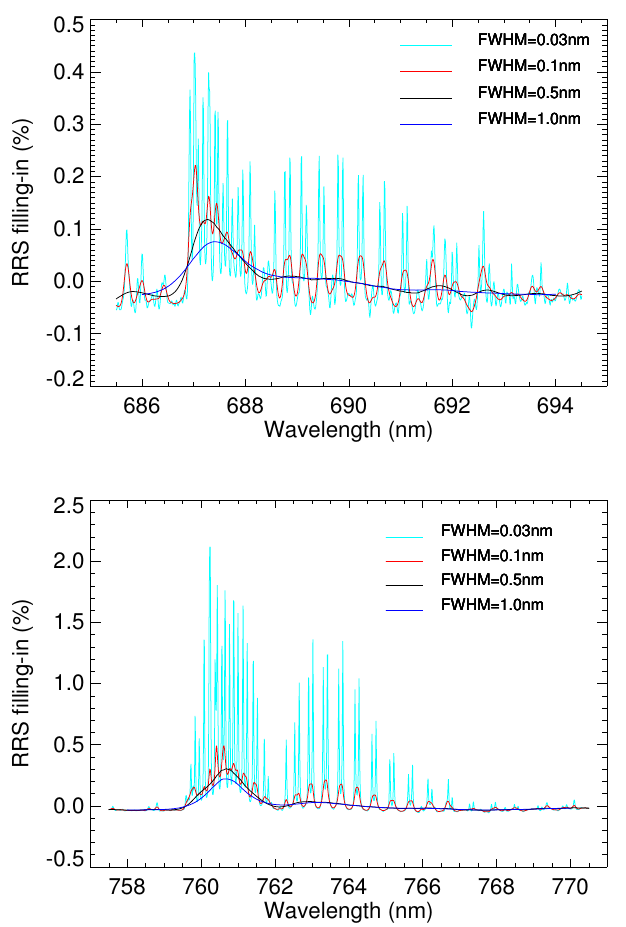
Fig. 4. Percentage of filling-in from RRS for SZA=45 ◦ , at nadir, for wavelengths in and around the O 2 B-band and surface reflectivity Fig. 4. Percentage filling-in from RRS for SZA = 45 ◦ , at nadir, for wavelengths in and around the O 2 B-band 0.05 (top) and O 2 A-band and surface reflectivity 0.3 (bottom). and surface reflectivity 0.05 (top) and O 2 A-band and surface reflectivity 0.3 (bottom).